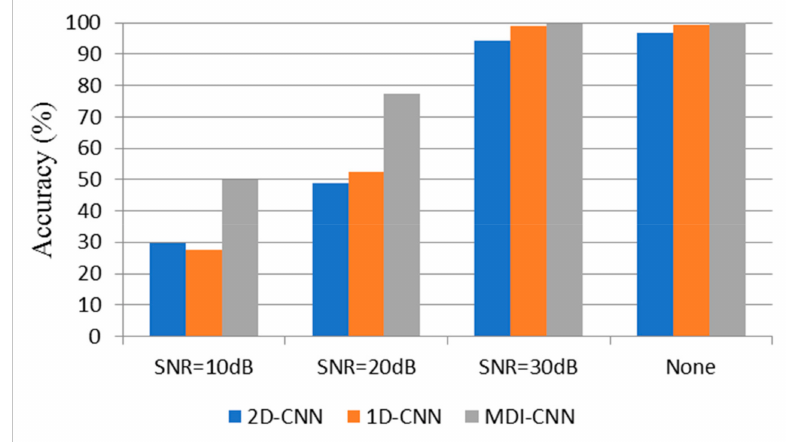
Figure 9. Testing diagnosis results of di ff erent models under di ff erent noise intensity.